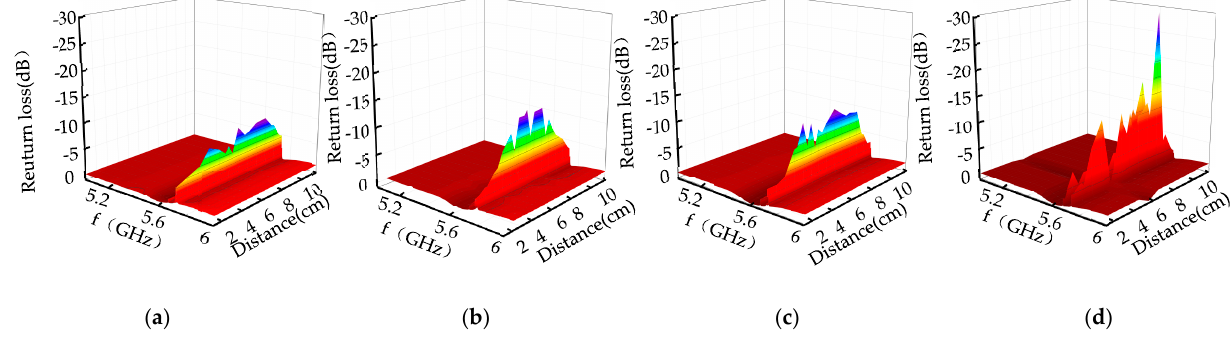
Figure 19. Microwave detection signals of different cylindrical defects. ( a ) Cone defect. ( b ) Hemi- spheric defect. ( c ) Cylinder defect. ( d ) Half ‐ cylinder defect.